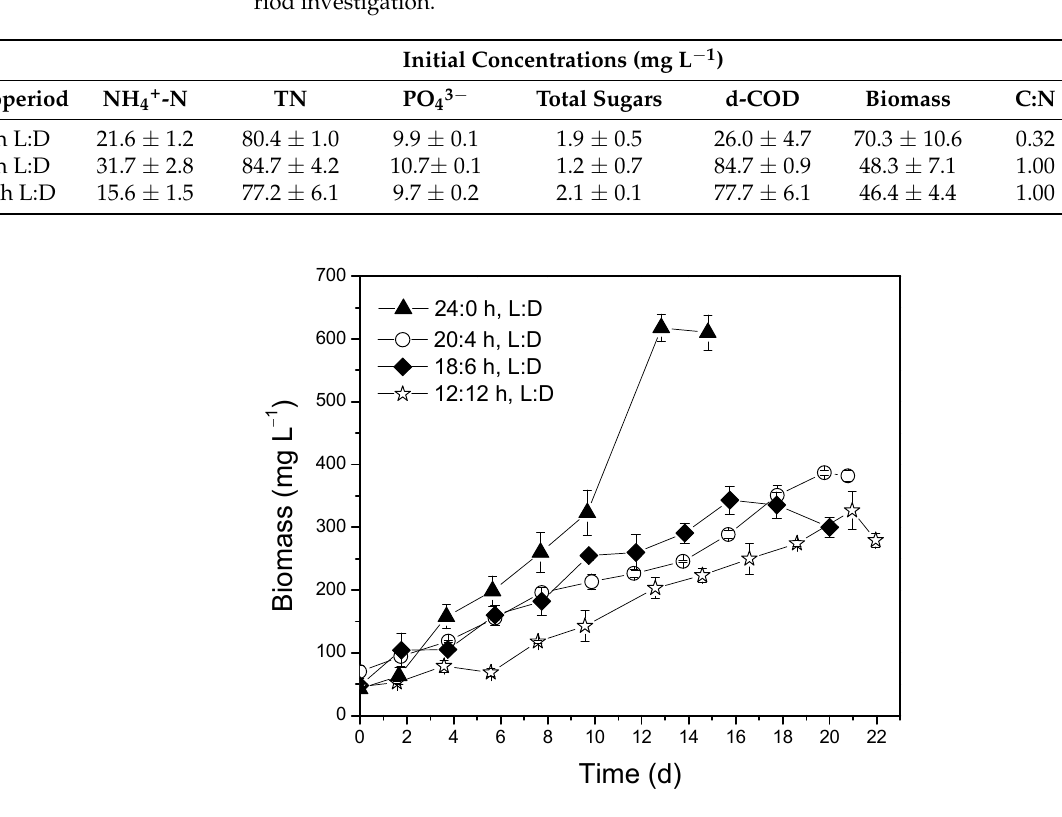
Figure 5. Effect of photoperiod on the biomass production of T. striata . Table 11. Nutrient reduction rates, biomass productivity and specific growth rates in experimental sets for optimum photoperiod